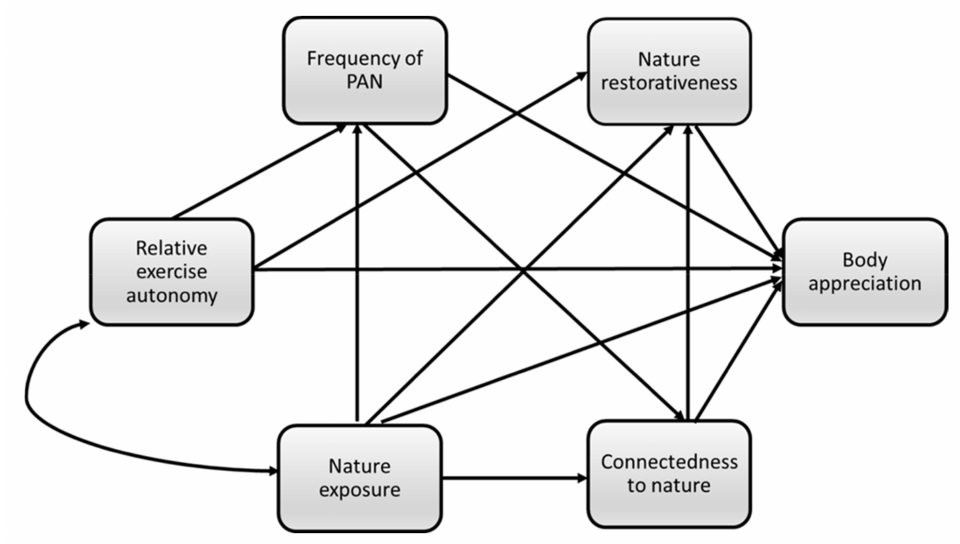
Figure 1. Hypothesized model of the associations between study variables. PAN = physical activity in